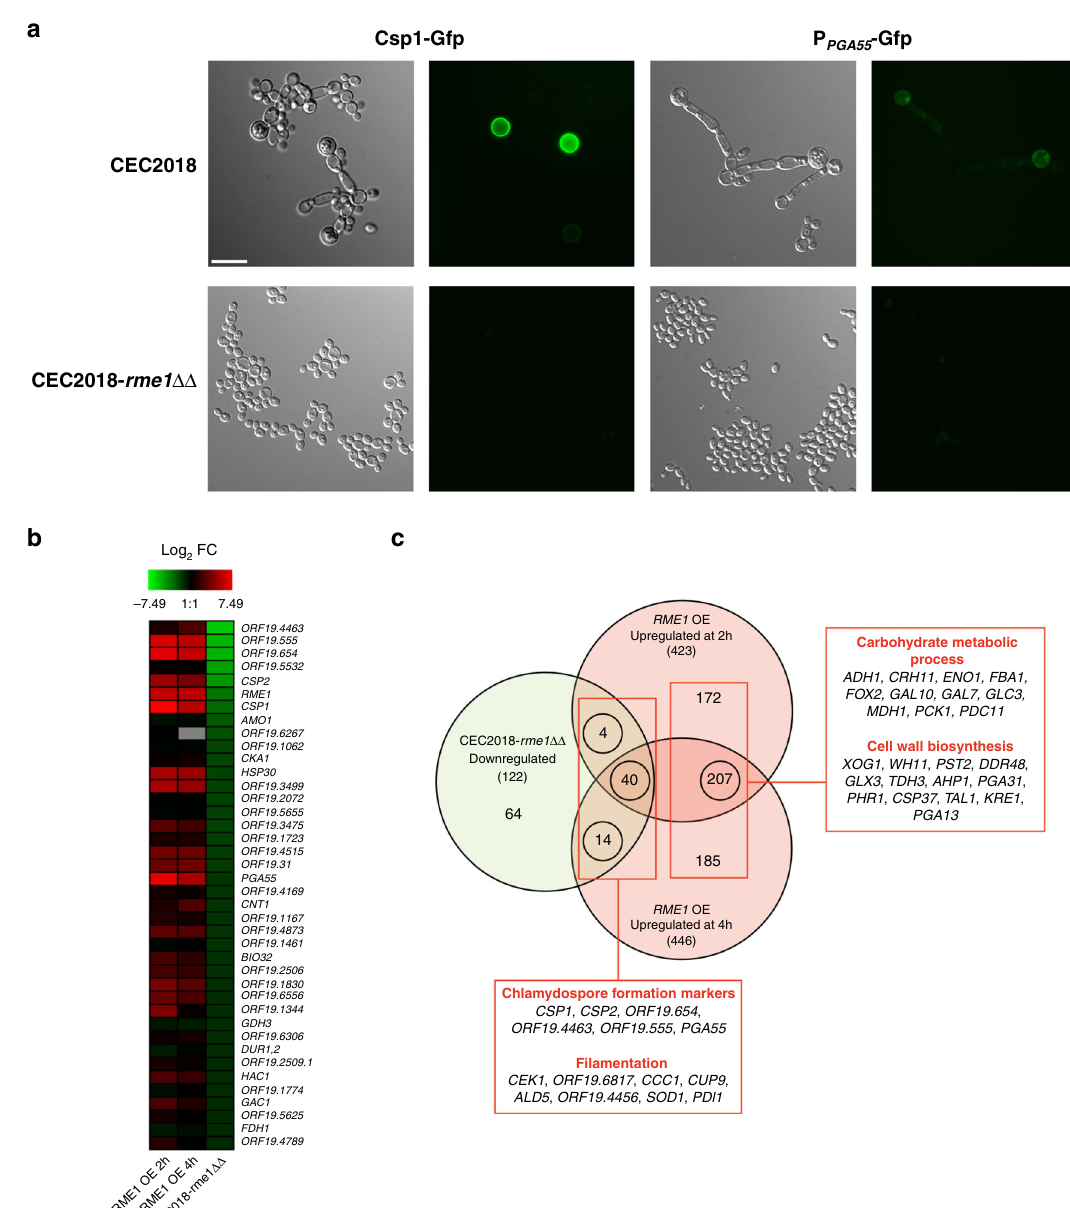
Fig. 4 RME1 disruption in the clinical isolate CEC2018 con fi rms Rme1 involvement in chlamydosporulation. a Strain CEC2018 and the CEC2018- rme1 ΔΔ derivative expressing the CSP1 - GFP (left panels) and P PGA55 - GFP (right panels) fusions were cultured in PCB liquid medium at 25 °C for 24 h and then inspected by phase contrast and fl uorescence microscopy. Scale bar = 10 μ m. b Heat map comparing the downregulated genes in the transcriptomic analysis performed in the CEC2018- rme1 ΔΔ strain (gene expression fold-change ≤ − 1.5; P < 0.05, n = 3 independent biological replicates) and the upregulated genes at 2 h and 4 h in the expression pro fi ling in the strain expressing P TET - RME1 (gene expression fold-change ≥ 1.5; P < 0.05; statistical signi fi cance was assessed using a two-tailed Welch ’ s t -test, n = 3 independen t biological samples). c Venn diagram showing the overlap between the upregulated genes by P TET - RME1 at 2 h and 4 h (gene expression fold-change ≥ 1.5; P < 0.05, n = 3 independent biological replicates) and the downregulated genes (gene expression fold-change ≤ − 1.5; P < 0.05, n = 3 independent biological replicates) in the CEC2018- rme1 ΔΔ strain. Numbers in Venn diagram represent the number of modulated genes and those between parentheses indicate the total number of upregulated genes upon RME1 overexpression (light red circles) and downregulated ones in the rme1 ΔΔ mutant (light green circle). Circled numbers represent the overlap of transcriptionally modulated genes in both experiments. The linked red box shows the name of a few genes and their corresponding functional categories. Statistical signi fi cance was assessed using a two-tailed Welch ’ s t